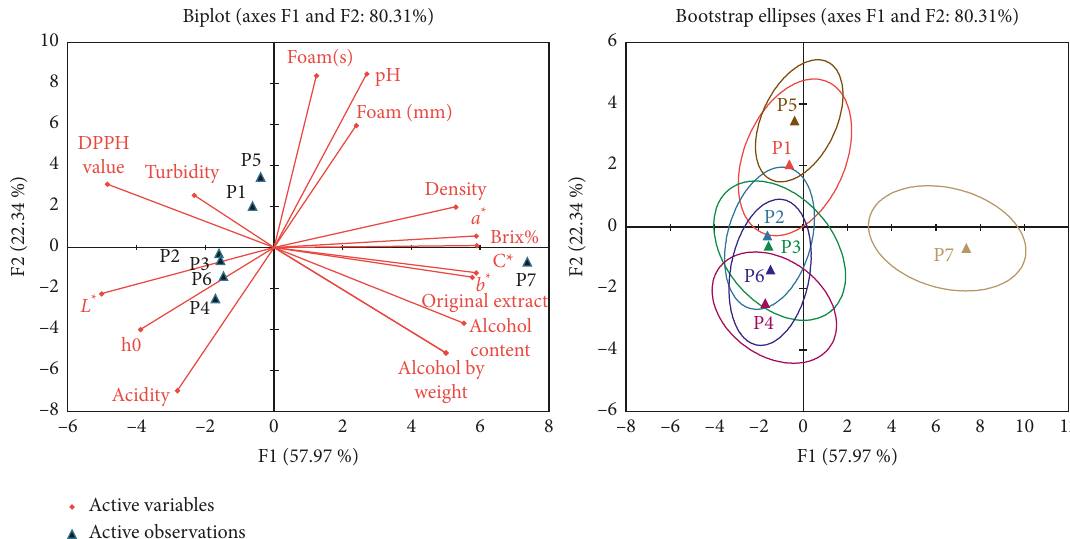
Figure 2: Principal component analysis of physicochemical properties of beers. Notes: F1 and F2 represent the first and second principal components of principal component analysis (PCA). P1–P6 represent the beer samples with 0.1g/mL, 0.08g/mL, 0.067g/mL, 0.057g/mL, 0.05g/mL, and 0.044g/mL FHV extraction, respectively. P7 represents the commercial